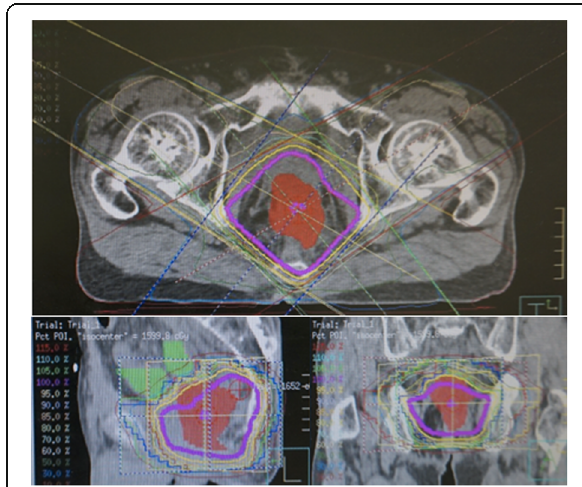
Fig. 3 Irradiation plan for the pelvic